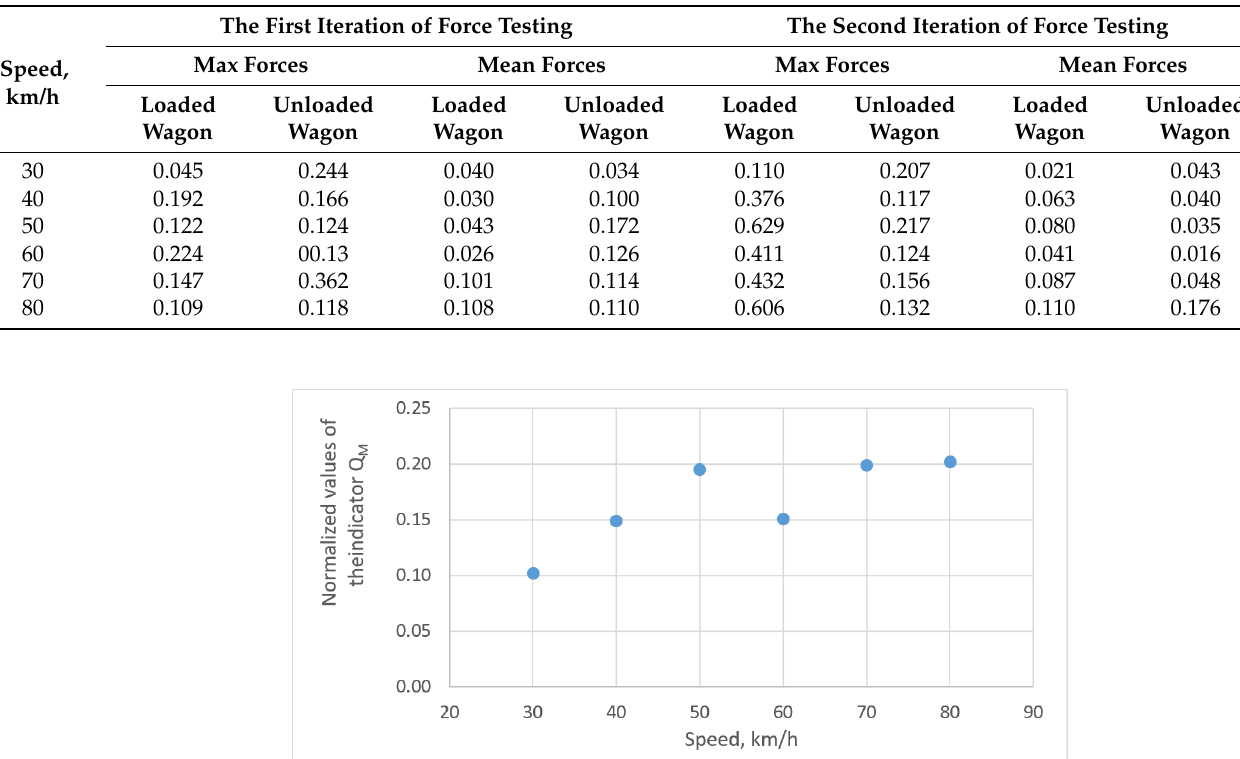
Table 1. Summarized Q M values.